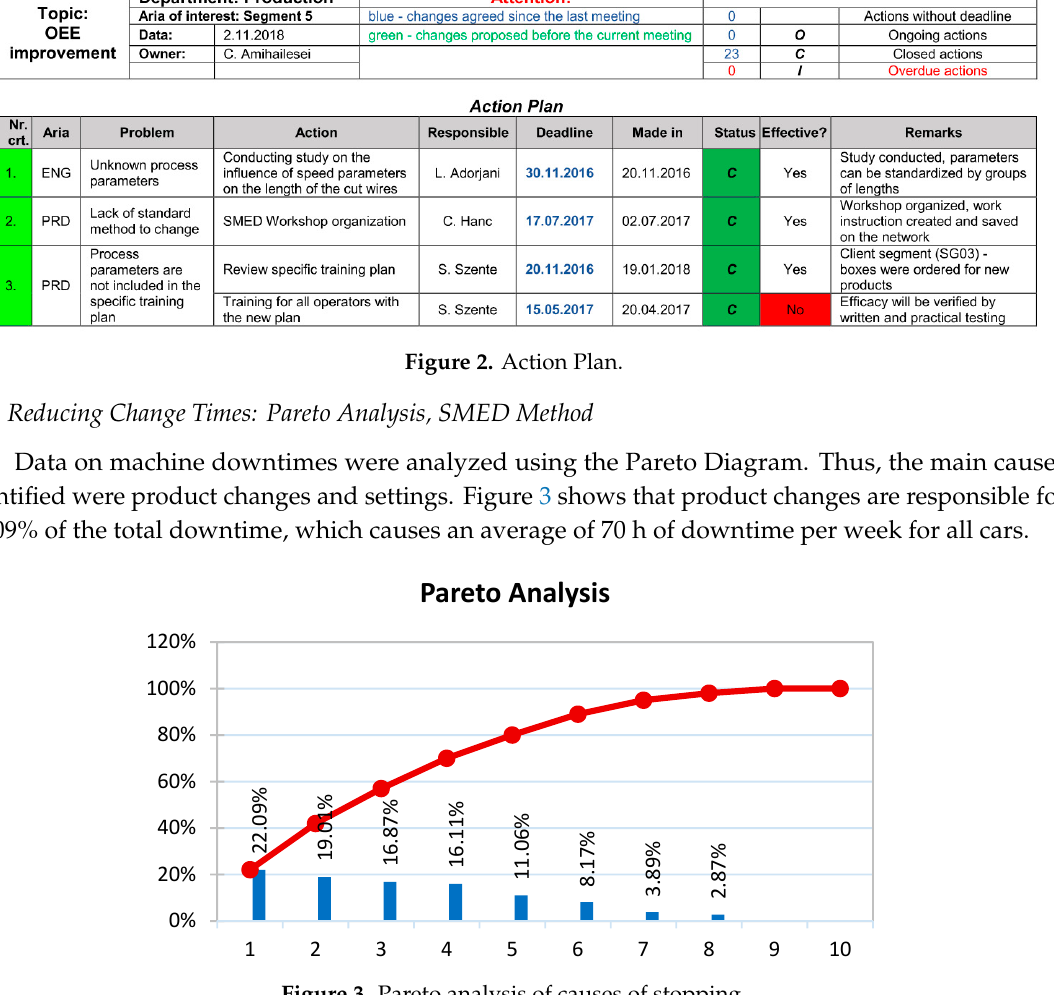
Figure 3. Pareto analysis of causes of stopping.